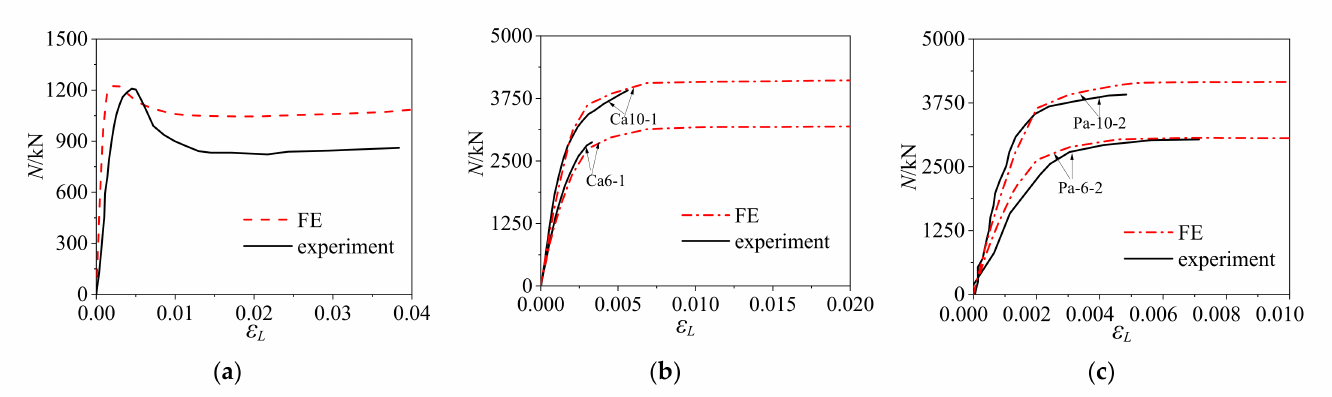
Figure 3. Comparison of FE and experimental load–strain curves: ( a ) CFT-SC [8], ( b ) Ca6-1 and Ca10-1 [9], and ( c ) Pa-6-2 and Pa-10-2